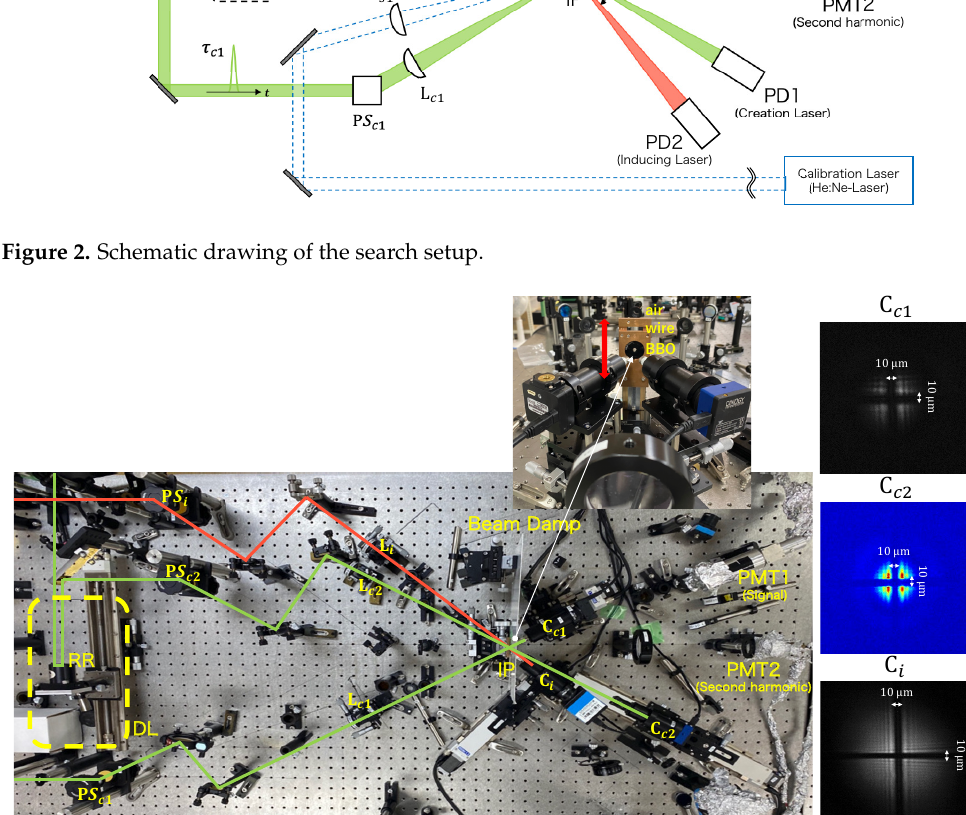
Figure 3. Photographs of the search setup ( left ) and the three focused laser spots ( right ) at a common thin cross-wire